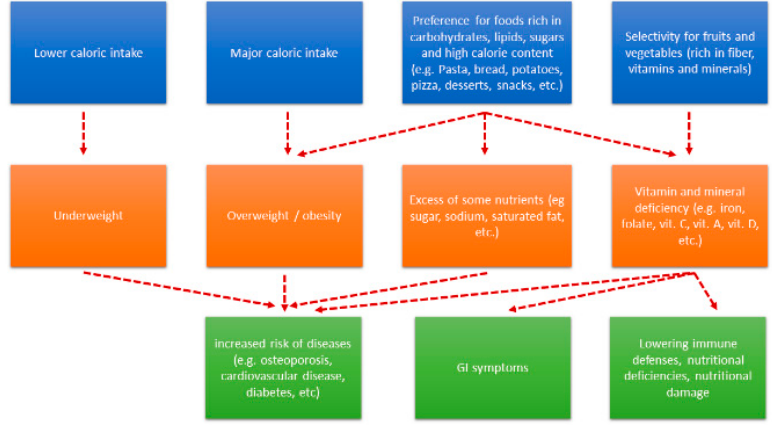
Figure 2. Synopsis of ASD food selectivity on nutritional status, anthropometric features and clinical conditions.